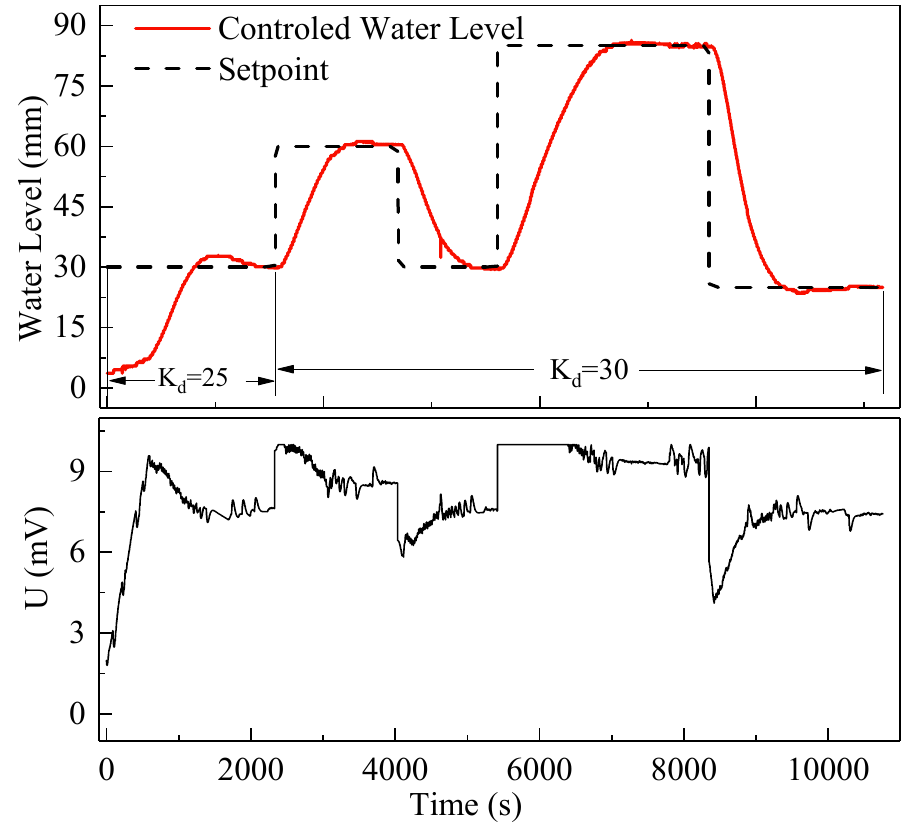
Figure 14. Water level tracking experiment with MADRC controller.